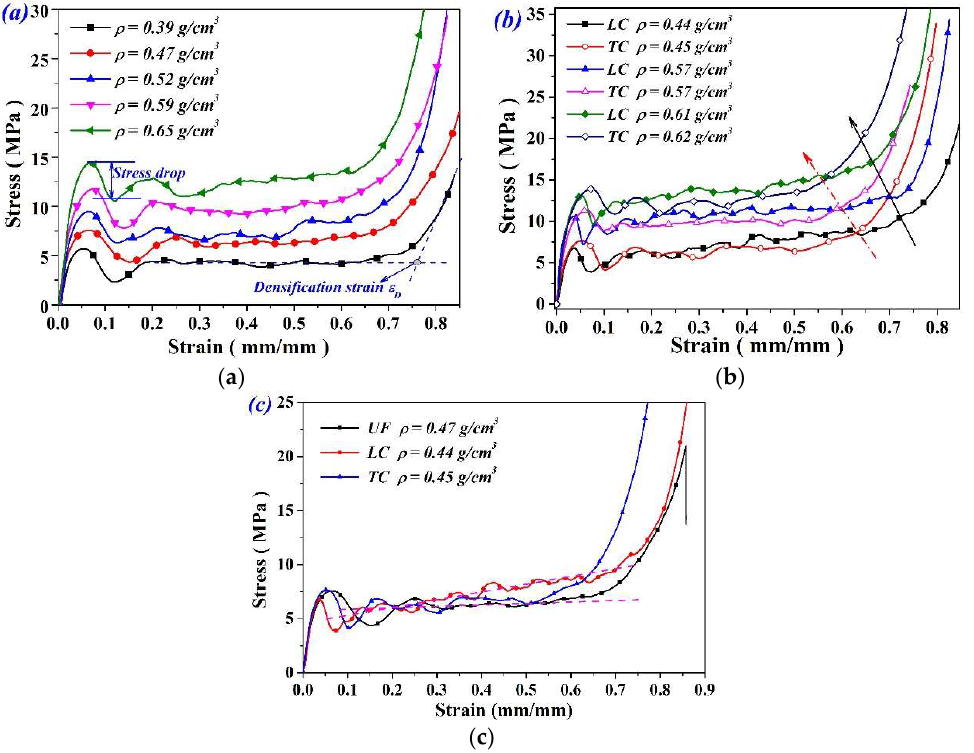
Figure 4. Mechanical response of ( a ) UFs and ( b ) FGs under quasi-static compression and ( c ) comparison of stress-strain response between UF and FG specimens.